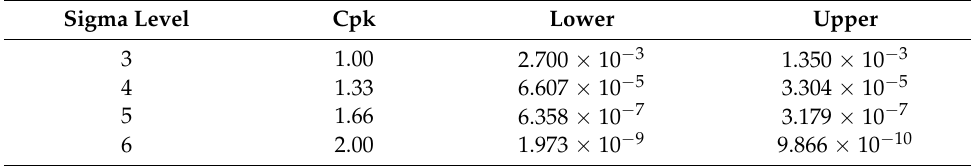
Table 1. Cpk values and defective proportions. Sigma Level